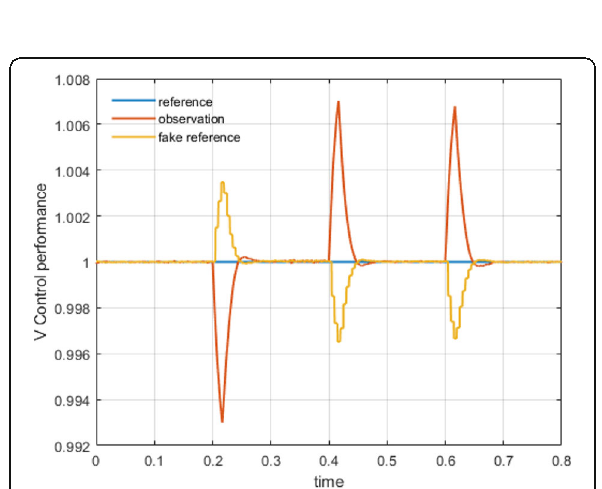
Fig. 3 (Abstract P5). Fake refernece and transient response of voltage at bus